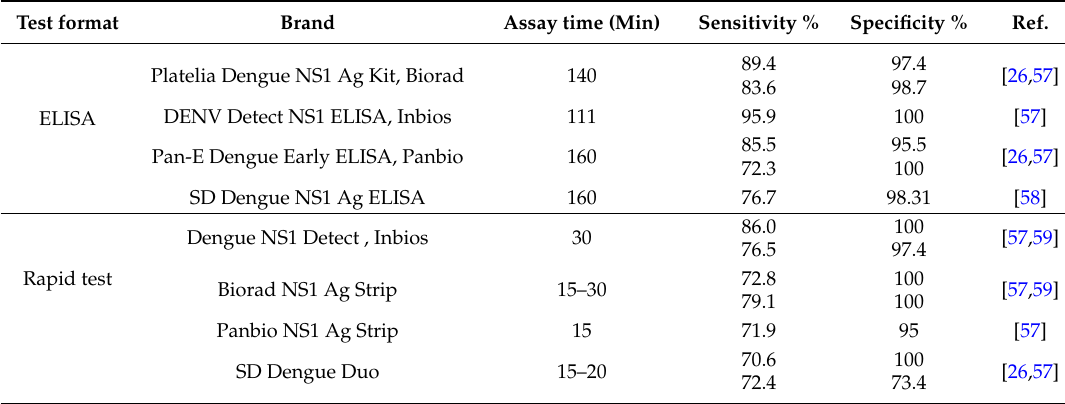
Table 3. Sensitivity and specificity of evaluated commercialized NS1 ELISA and rapid